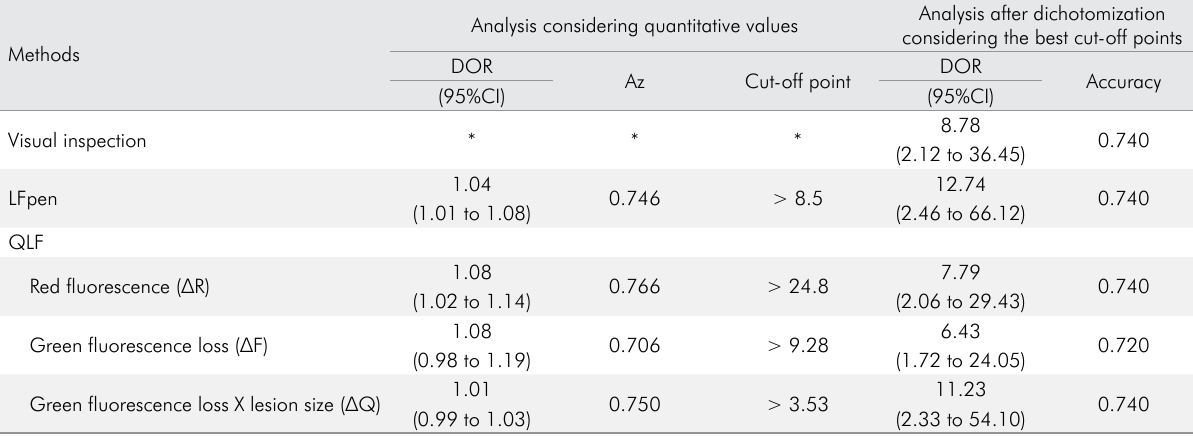
Table 4. Performance of visual inspection and fluorescence-based methods in assessing activity of occlusal caries lesions in primary teeth